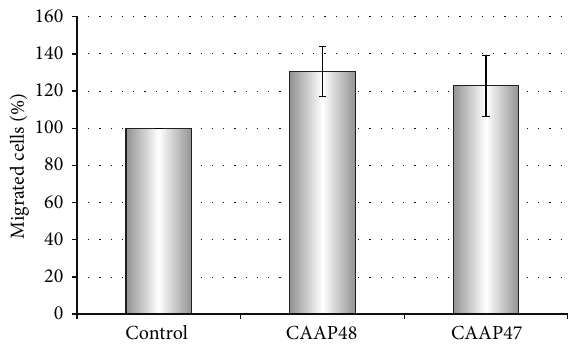
Figure 4: Chemotactic response of neutrophils to CAAP48 and the SNP-variant CAAP47. The chemotactic response of isolated neu- trophils to CAAP48 and the SNP-variant CAAP47 was examined using disposable Boyden chambers. The number of cells migrating to the lower wells of the chamber was assessed by microscopy and using a hematological analyzer after 60min. Control: RPMI 1640 medium alone; CAAP48 and CAAP47 were used at a concentration of 100 𝜇 M (480ng/ 𝜇 L). CAAP48/CAAP47 dependent migration was normalized to spontaneous migration in controls. Each bar represents the mean ± SD of three independent experiments.